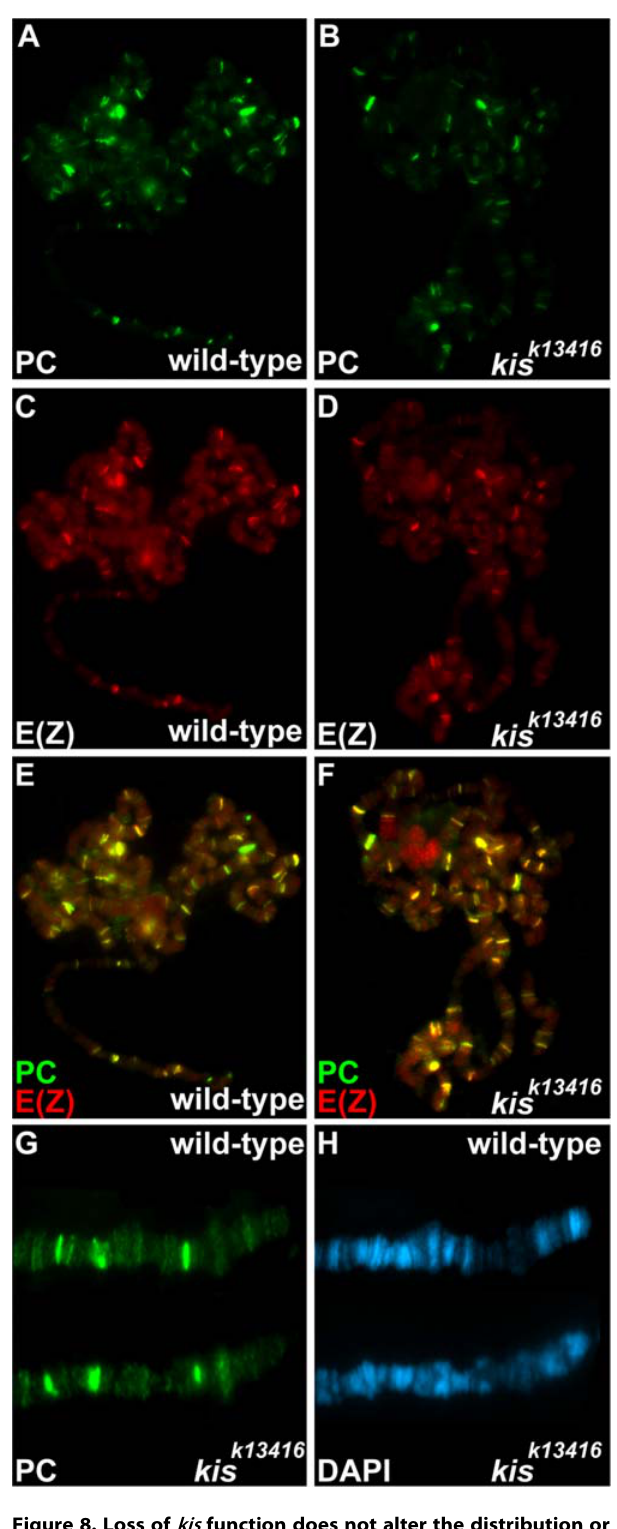
Figure 8. Loss of kis function does not alter the distribution or level of Polycomb group proteins. A–F) The distribution of PC (A, B, green) and E(Z) (C, D, red) and the merged images of PC and E(Z) (E, F) on polytene chromosomes isolated from wild-type (A, C, E) and kis k13416 (B, D, F) larvae are shown. G–H) Comparison of the distribution of PC on the distal tip of the X chromosome of wild-type and kis k13416 larvae (G), together with the corresponding DAPI staining (H). Note that the loss of kis function does not lead to obvious changes in the level or distribution of PC or E(Z). doi:10.1371/journal.pgen.1000217.g008 PLoS Genetics |